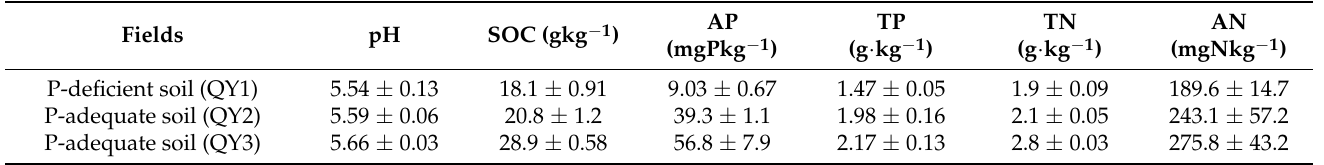
Table 1. Fertility status of different soil fields used in this